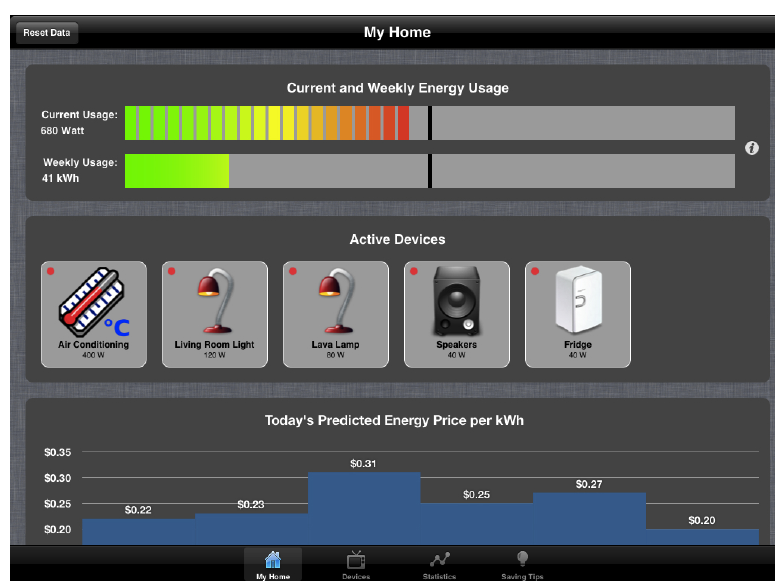
Figure 2. An example of a gauge visualization used in the USEM mobile app for showing the current power consummation data (at the top). Image from Reference